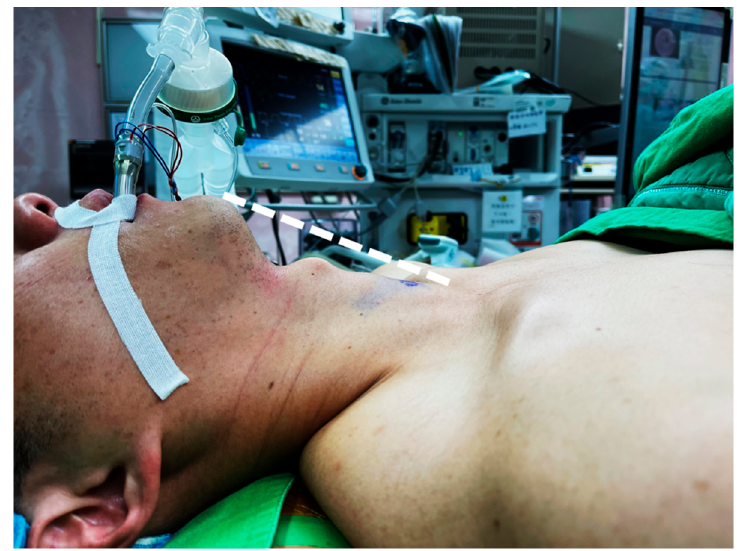
Figure 1. Patient was placed in slight neck extension. The loose skin can be lifted (dotted line) after CO 2 insufflation and provide sufficient working space for instrumentation.